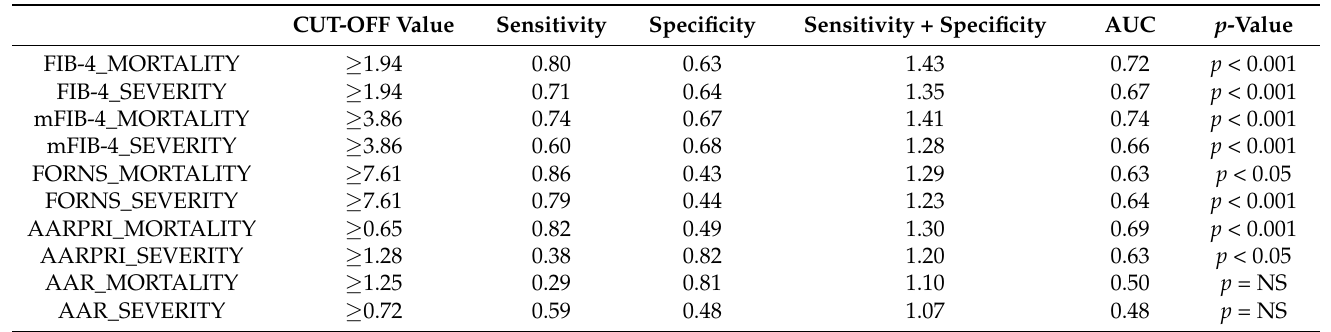
Table 3. ROC curve analyses scores of noninvasive liver fibrosis for FORNS, FIB-4, mFIB-4, AAR, and AARPRI in prediction of mortality and severity.